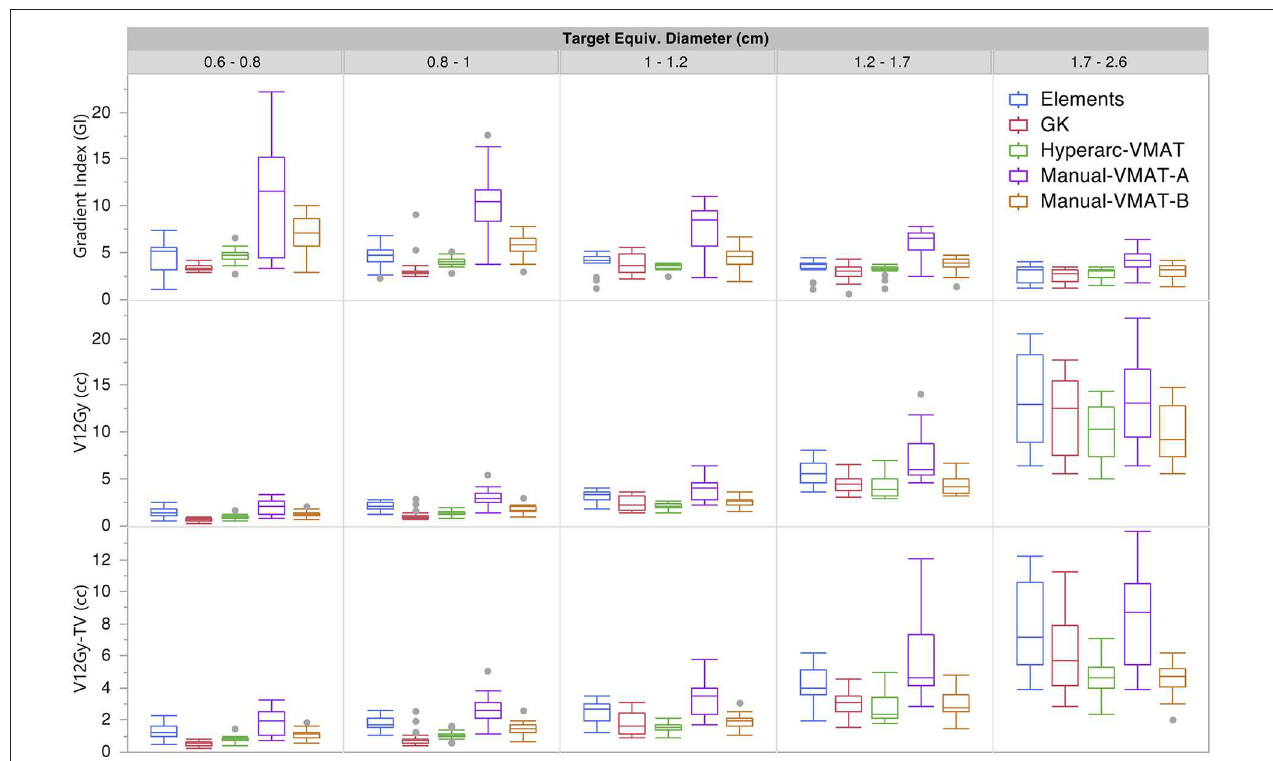
FIGURE 2 | Gradient Index (GI) , V12 Gy per target (defined as the volume of 12Gy delivered to the surrounding brain tissue contributed only from that individual target), and V12 Gy -TV(defined as the total volume of brain receiving 12Gy per target excluding the target volume) results displayed as box plots per SRS plan type, divided into five separate target size diameter bins.